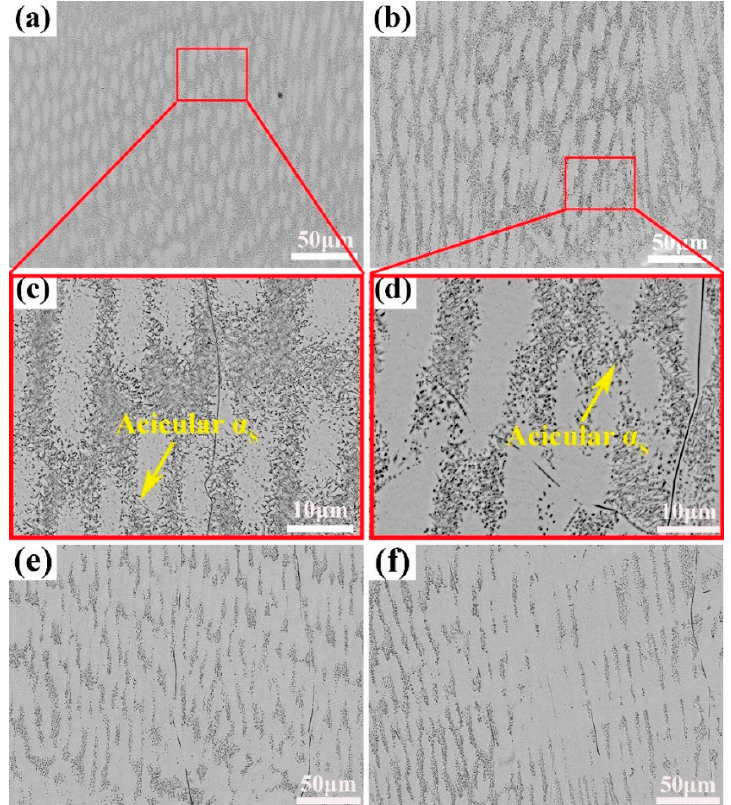
Figure 7. Microstructures of annealed samples at different temperatures for 0.5 h: ( a ) 650 °C; ( b ) 750 °C; ( c ) and ( d ) corresponding high-magnification morphologies of ( a ) and ( b ), respectively; ( e ) 850 °C; ( f ) 925 °C.